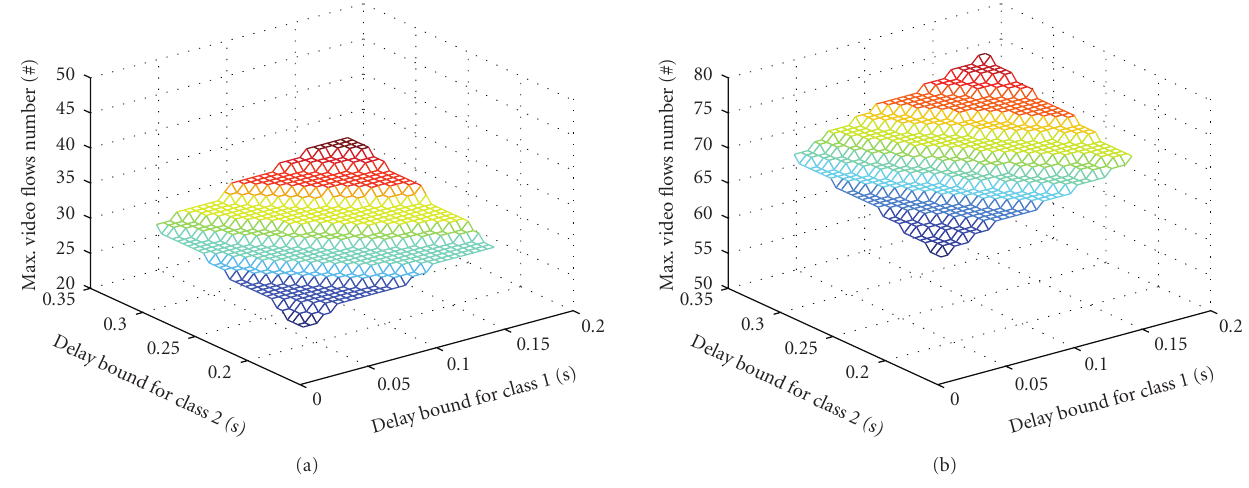
Figure 5: The number of admitted flows using di ff erent admission control schemes. (a): using the rate guarantee-based admission control. (b): our proposed rate-variance-based admission